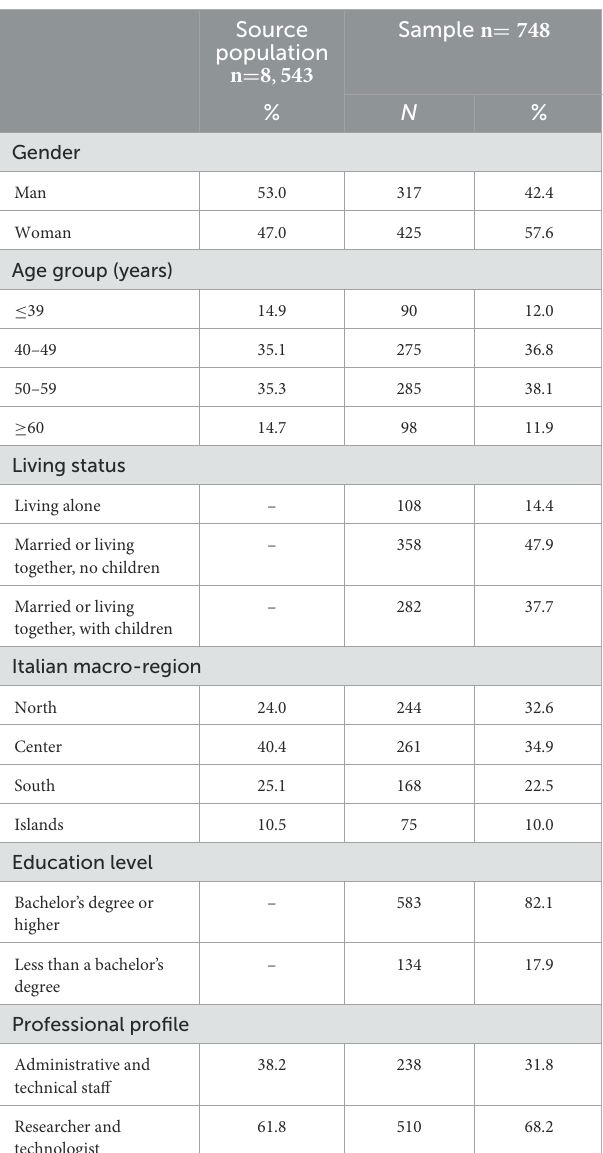
TABLE 1 Participants’ general characteristics. Comparison with the source population as of December 2021, 31st, excluding managers, where feasible. Source